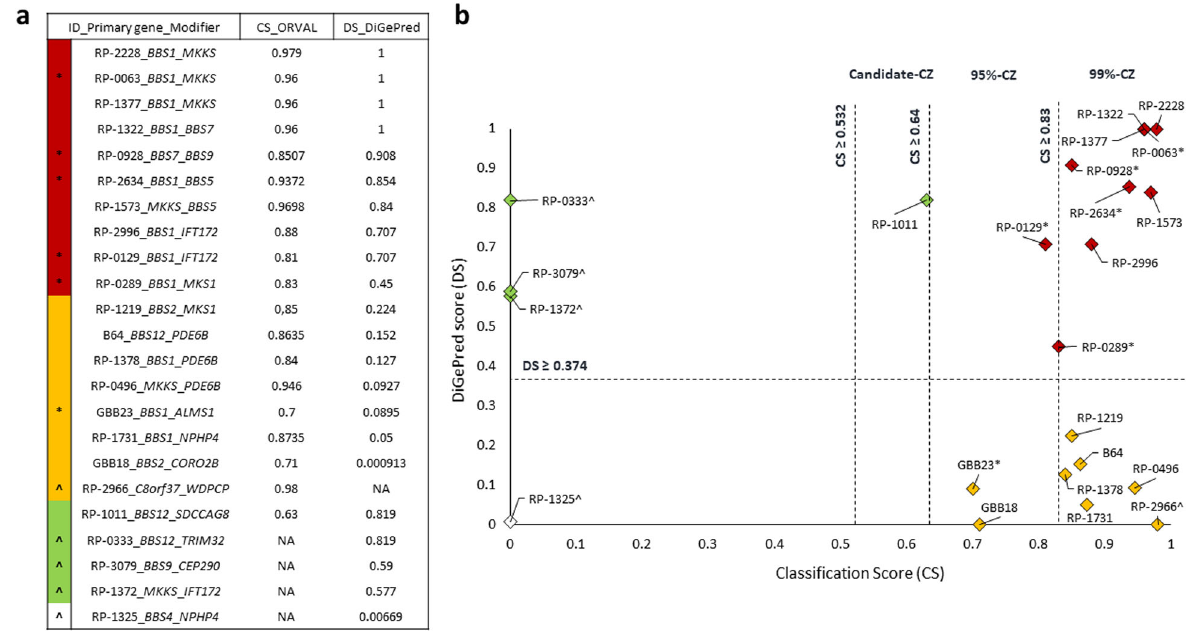
Fig. 3 Predicted oligogenic effects of allelic combinations in BBS-related genes. a List of the allelic combination of the 23 families and their DiGePred and ORVAL scores. The families were grouped according to the scores obtained in those two in silico tools in (i) high con fi dence in both methods (red color), gene pair with digenic disease potential (DiGePred Score (DS) ≥ 0.374), and predicted oligogenic combination of variants with a con fi dence of at least 95% (Classi fi cation Score (CS) ≥ 0.64); (ii) high con fi dence for genes with digenic potential, DS ≥ 0.374 (green); (iii) high con fi dence for the oligogenic combination, but in genes with lower potential for digenism, 95%-zone candidate in ORVAL (CS ≥ 0.64) (orange); and iv) combinations in which digenic potential is discarded (white). ^Predictions in one of the methods could not be made for fi ve allelic combinations. *Six families in which phenotypic and allelic differences between affected siblings were reported. b Graphic representation of the scores obtained in DiGePred and